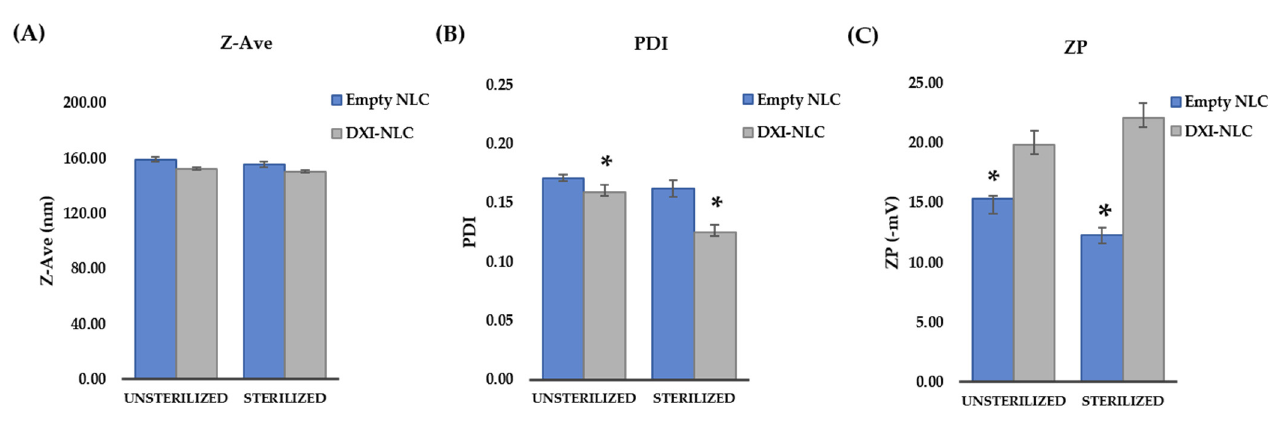
Figure 8. Effect of gamma sterilization on DXI-loaded nanostructured lipid carriers (NLC). ( A ): bar chart for sterilization effect on size (Z-Ave) of empty NLC and DXI-NLC; ( B ): bar chart for sterilization effect on polydispersity index (PDI) of empty NLC and DXI-NLC; ( C ): bar chart for sterilization effect on zeta potential (ZP) of empty NLC and DXI-NLC; * significant difference.